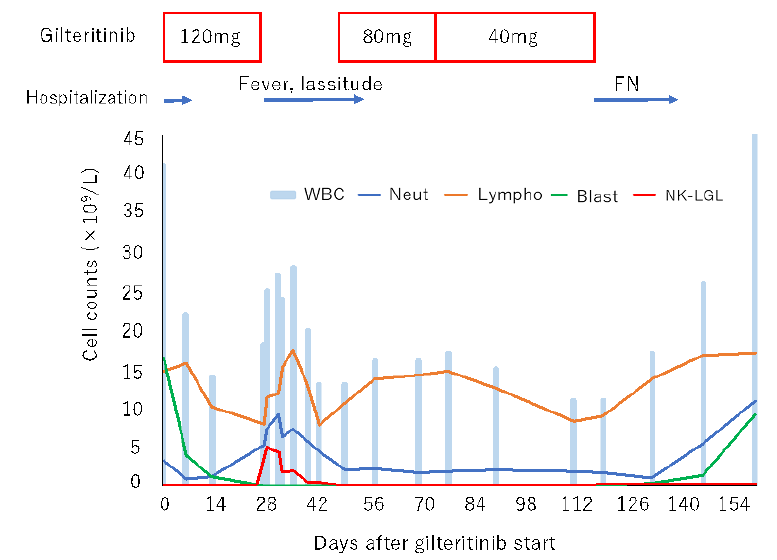
Figure 2. Clinical course from the start of gilteritinib therapy to progression disease. The patient had achieved partial response (PR) immediately because of gilteritinib treatment. Natural killer cell large granular lymphocytes (NK-LGL) was detected at the early stage of gilteritinib treatment and gradually decreased in about 2 weeks. The patient was hospitalized owing to fever, lassitude, and febrile neutropenia (FN), but long-term outpatient management was possible. Acute myeloid leukemia (AML) eventually could not be controlled but PR persisted for approximately 4 months.